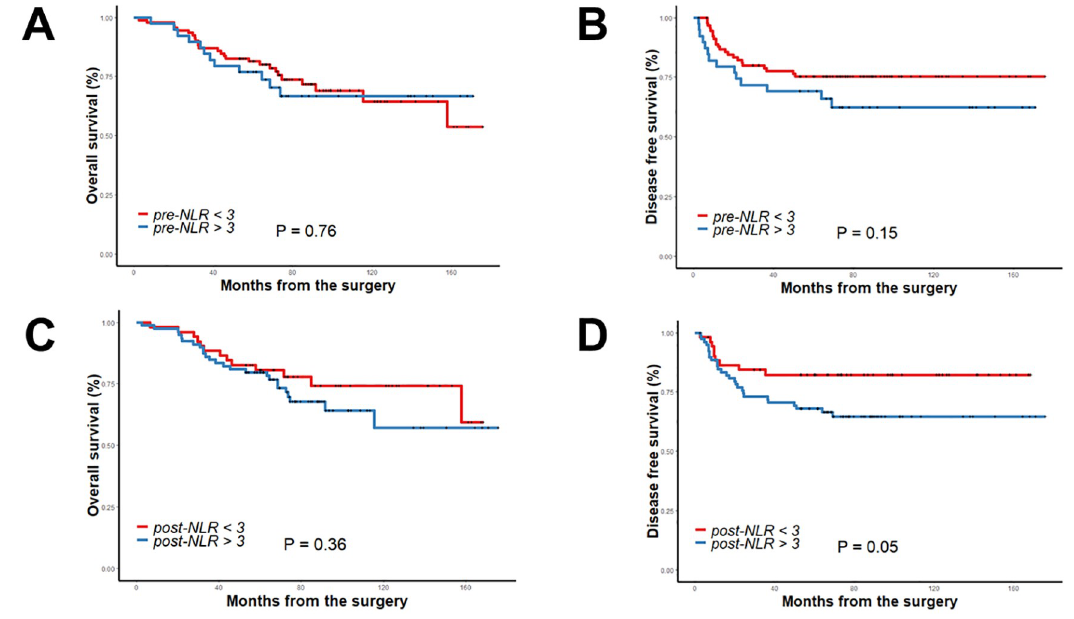
Fig 1. Overall survival and disease-free survival according to cut-off value 3 of pre-NLR (A, B) and post-NLR (C, D). https://doi.org/10.1371/journal.pone.0214415.g001 Kaplan-Meier plot showed no survival difference between the groups (S1 Fig, Fig 1A–1D). Even when we re-classified those four groups into the two groups, such as pre-PLR < 154.4 & post-PLR < 255.7 vs. control or pre-LMR < 5.42 & post-LMR < 3.15 vs. control, there was no survival difference between the two groups. When the patients were dichotomized as pre-